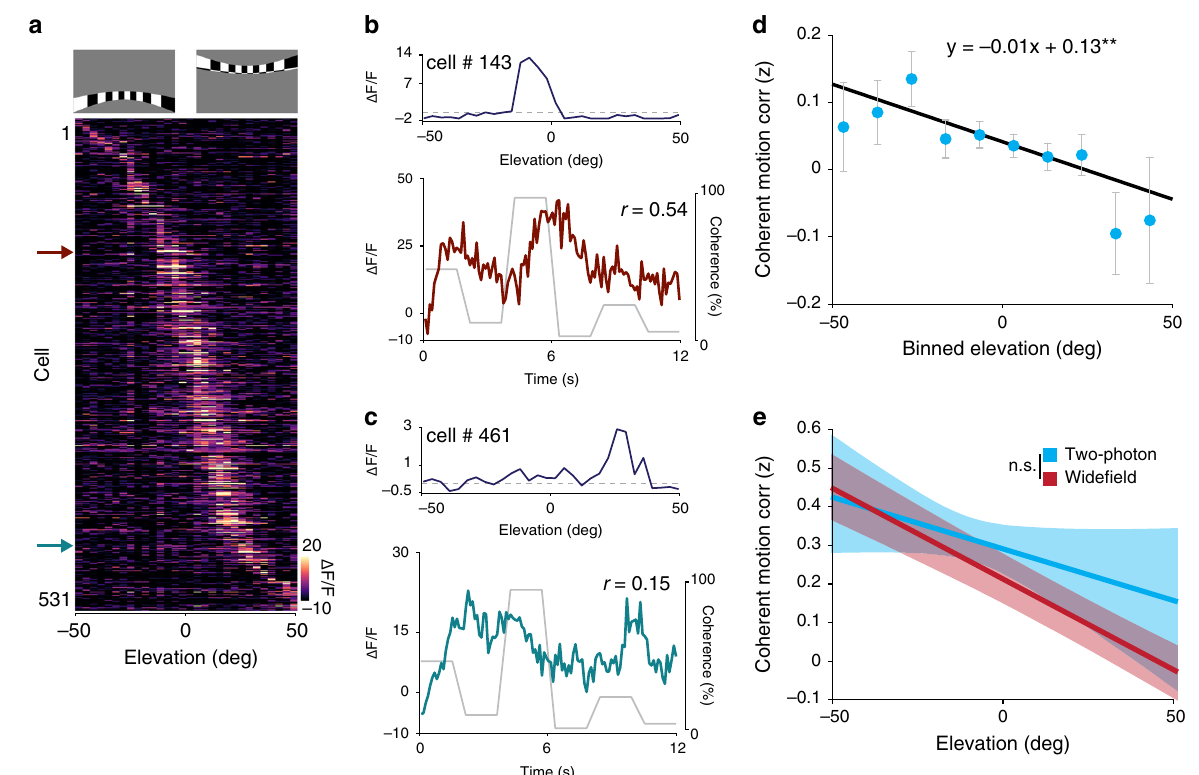
Fig. 7 Retinotopic asymmetry of single-cell coherent motion correlations in V1. a Top: examples of a high elevation and low elevation spherically corrected retinotopic bar stimulus. Bottom: averaged responses of each cell in the fi eld to the elevation retinotopic bar stimulus, ordered by elevation preference. b , c Top: the preferred elevation location of the speci fi ed cell. Bottom: the calcium response of the cell during the RDK stimulus, with the coherence trace overlaid. d Plot of elevation preference versus z -scored coherent motion correlation with neurons averaged within 10° elevation bins ( n = 2680 cells from 13 mice). Error bars are mean ± s.e.m. e Plot of mean elevation preference versus coherent motion correlation averaged across experiments for wide- fi eld (red) and two-photon experiments (blue). The con fi dence band represents the bootstrapped 95% con fi dence intervals of the slope and intercept (wide fi eld vs. two-photon: p = 0.51, two-tailed unpaired two-sample t test). ** p <